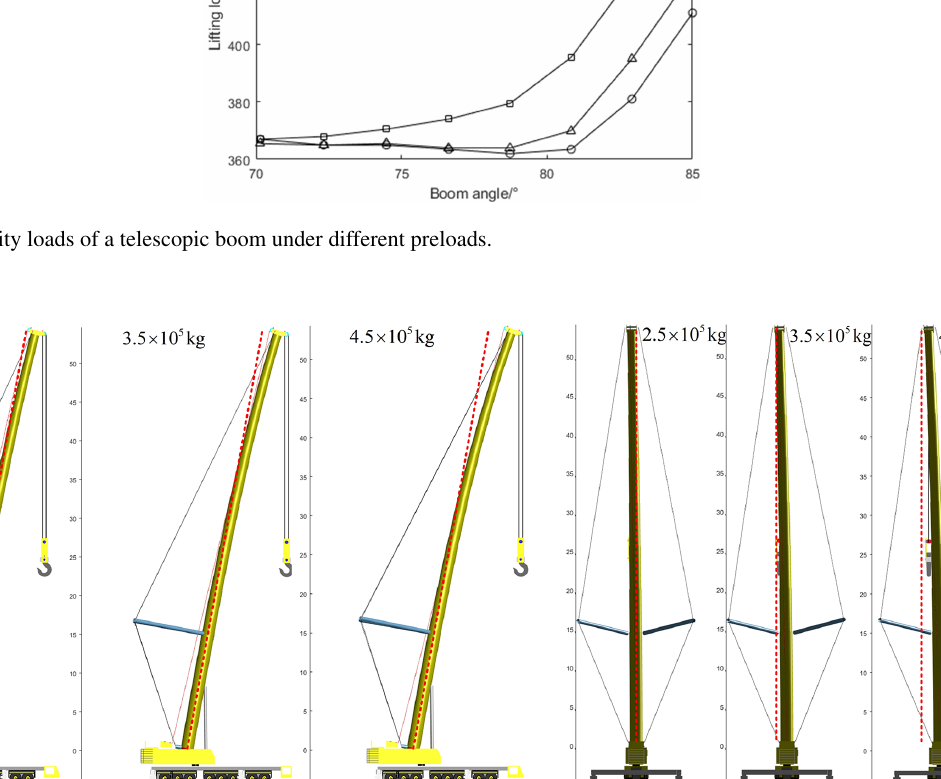
Mech. Sci., 13, 991–1009, 2022